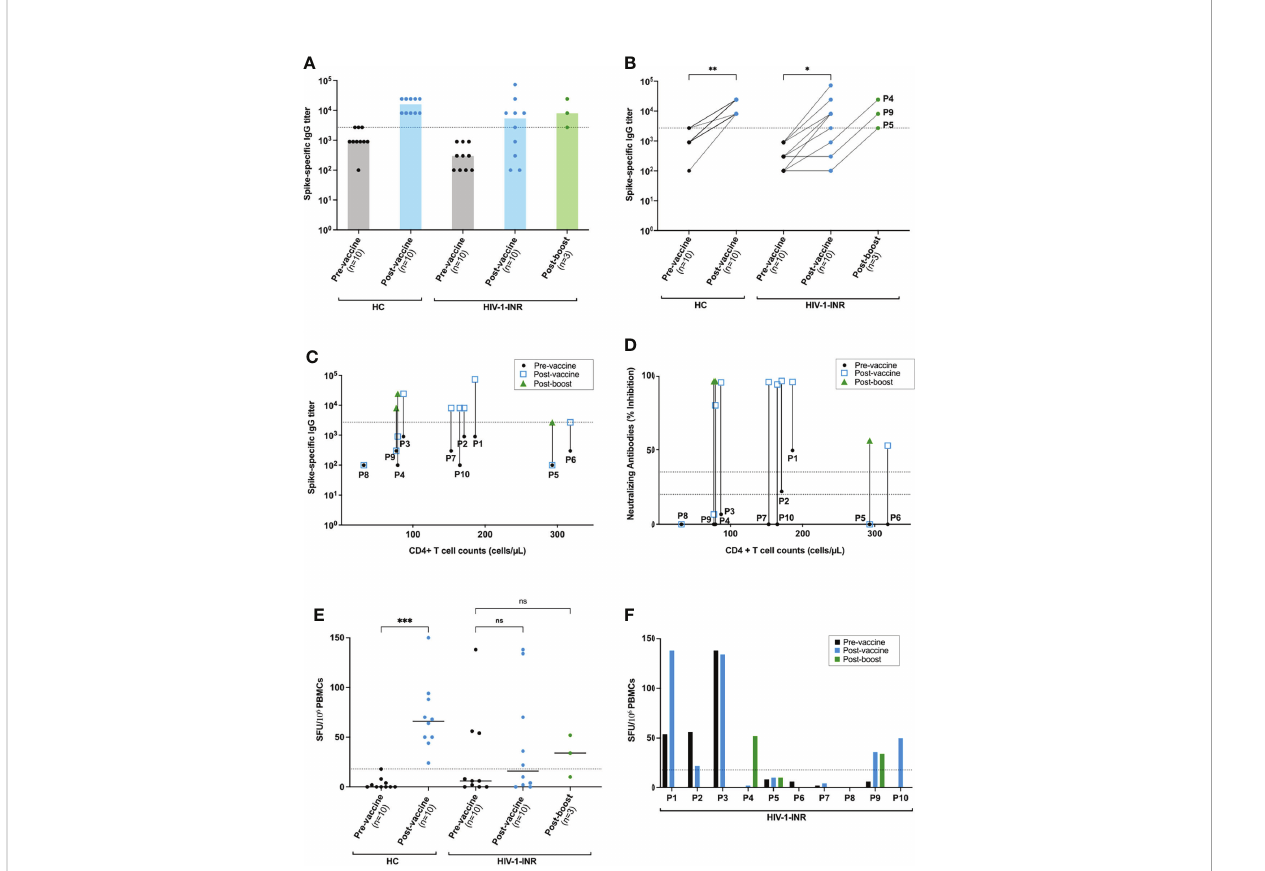
FIGURE 1 Spike-speci fi c anti-SARS-CoV-2 antibody and cellular responses in HIV-INR and healthy donors after mRNA-based COVID vaccination. (A, B) IgG Spike-speci fi c titers determined by ELISA for both of the 2 cohorts: healthy controls (HC) and HIV-INR at the 3 de fi ned time-points: pre- vaccination (pre-vaccine), post-vaccination (post-vaccine) and, for the HIV-INR non-responder patients, 3 w post boost vaccination (post- boost). IgG Spike-speci fi c titers of the HIV-INR (C) and individual inhibition percentages (% IH) against RBD determined by NeutraLISA (D) of all the HIV-INR patients taking into account their individual CD4+ T cell counts at the 3 different time-points. (E) IFN- g ELISpot values (SFU per 10 6 PBMCs) for all healthy individuals (HC) and HIV-INR patients at the 3 different time-points after in vitro stimulation with overlapping Spike peptides of SARS-CoV-2. (F) IFN- g ELISpot values for individual patients. Differences between the groups were calculated using Mann – Whitney test or Kruskal-Wallis test for comparison of two groups. Non-signi fi cant differences were indicated as “ ns ” . P-values below 0.05 were considered signi fi cant and were indicated by asterisks: *p< 0.05; **p < 0.01; ***p <